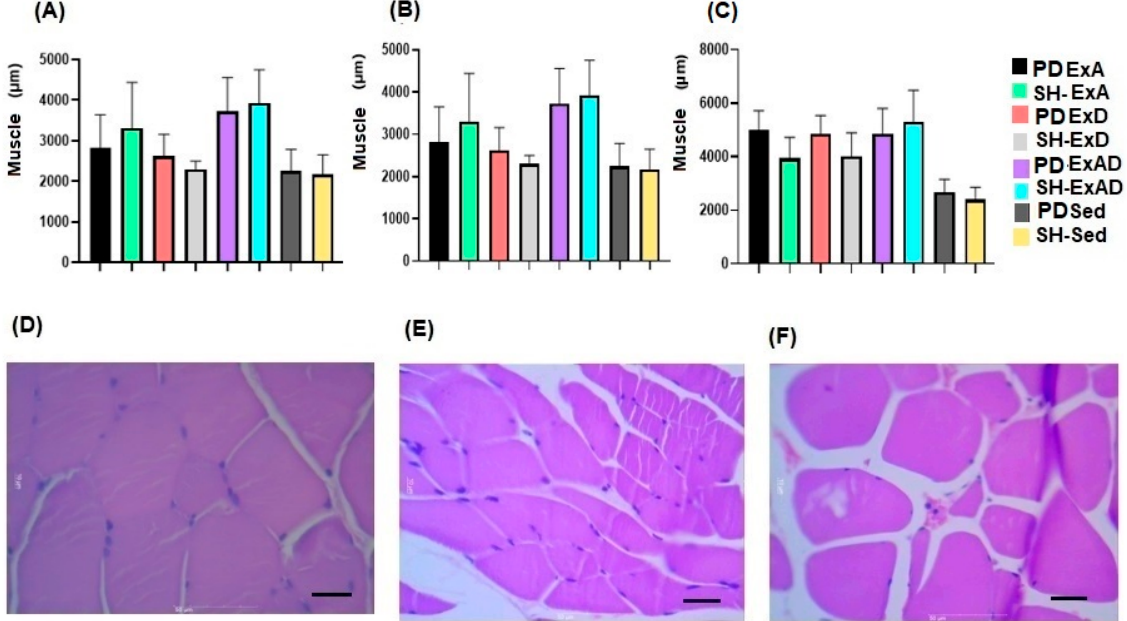
Figure 4. Analysis of the cross-sectional area of the respiratory muscles at 400 × magnification: ( A ) Diaphragm muscle, ( B ) Intercostal muscle, and ( C ) rectus abdominis muscle. Photomicrograph of the respiratory muscles: ( D ) diaphragm muscle ExAS, ( E ) intercostal muscle ExAS, and ( F ) rectus abdominis muscle ExAS.